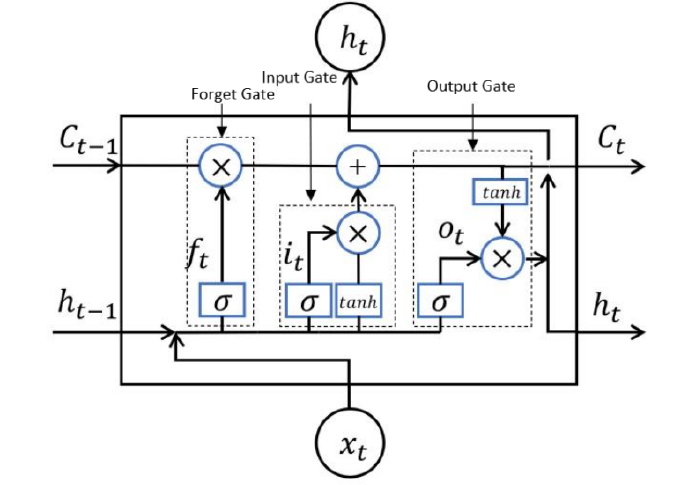
Figure 3. Structure of LSTM